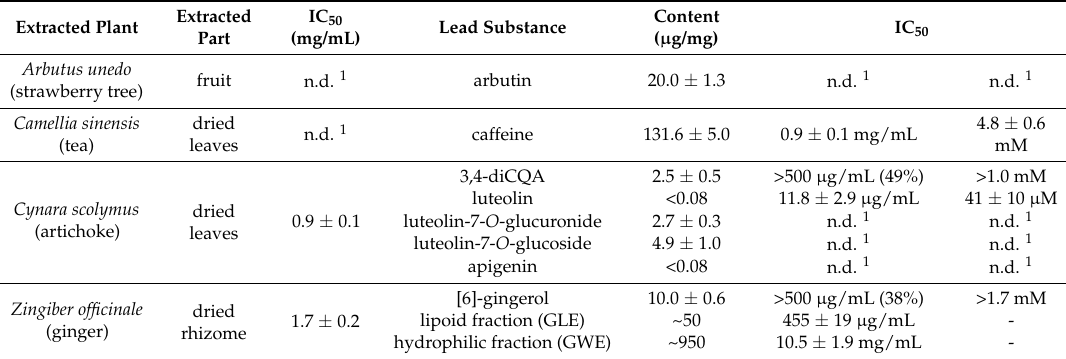
Table 1. Inhibition (IC 50 ) of cAMP-specific phosphodiesterase (PDE) by the four extracts and their constituent compounds. The content values are presented as the mean ± standard deviation of two independent experiments. Percentages in brackets represent inhibition at highest